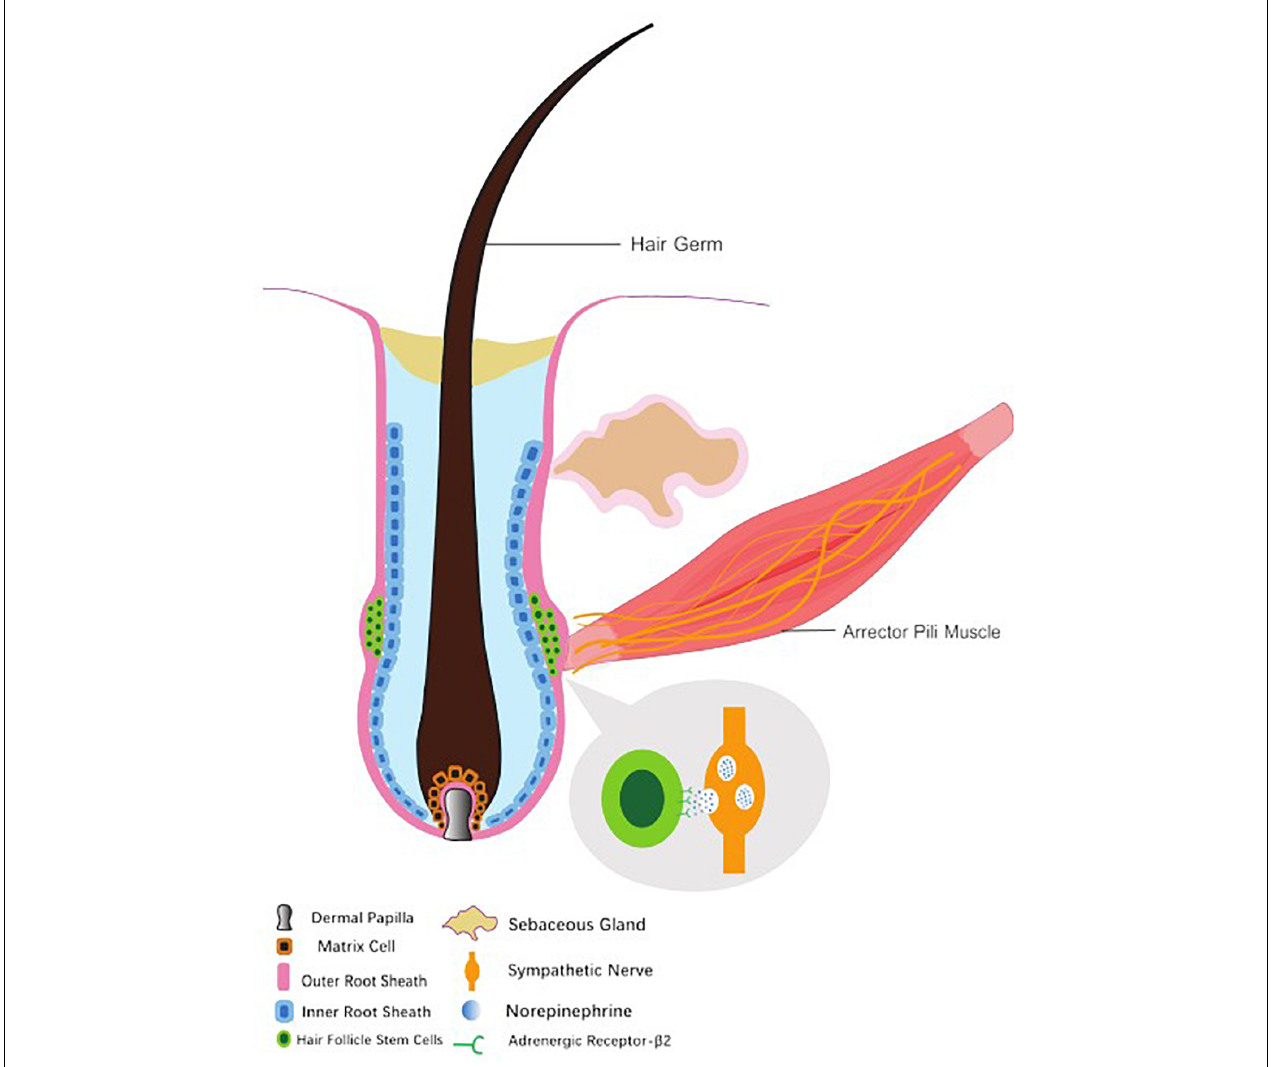
FIGURE 1 | Hair follicle structure, hair follicle stem cell and accessory organs. The arrector pili muscle provides as an anchor to maintain sympathetic innervation to hair. The sympathetic nerves form synapse-like connections with hair follicle stem cells and regulate them through vesicles containing